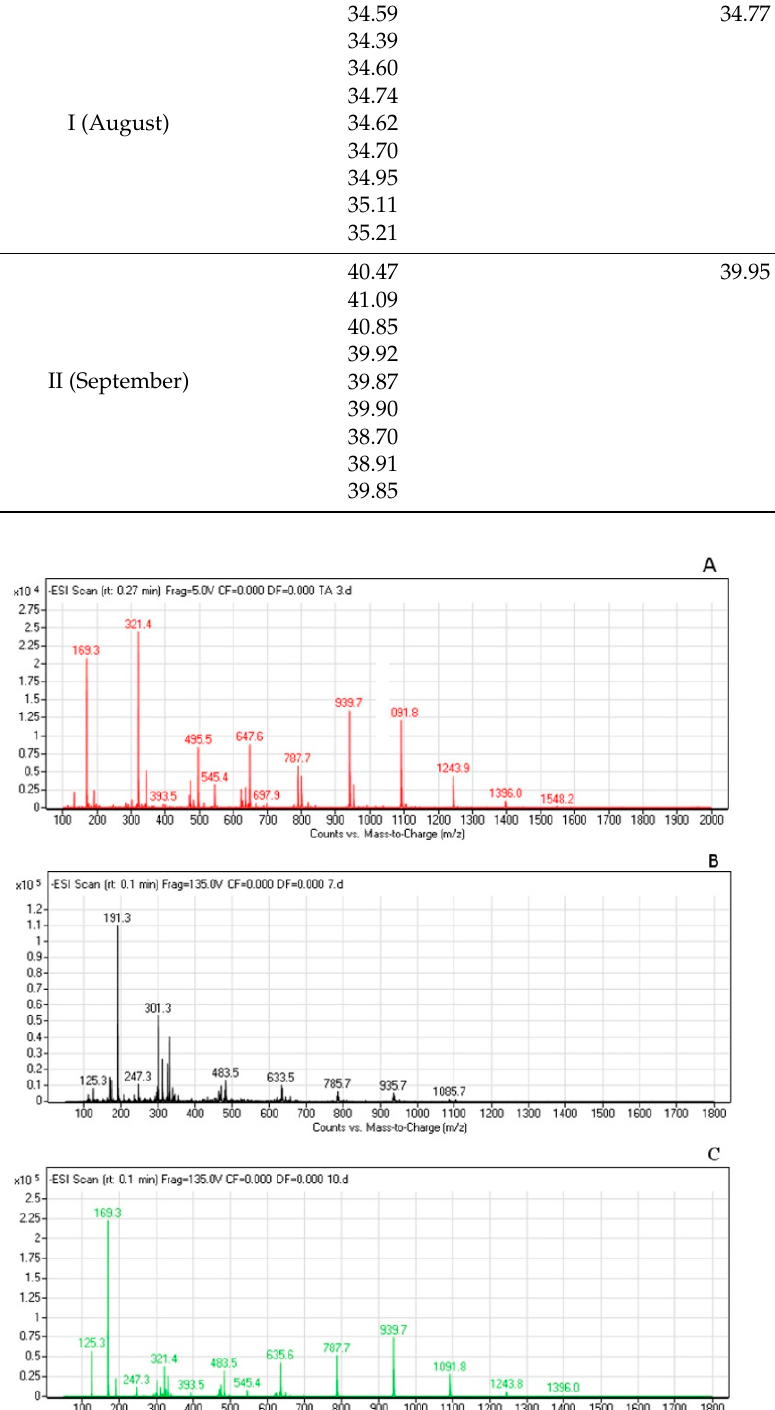
Figure 2. The mass spectrometric signature (-ESI SCAN) of: mixtures of gallic and tannic acid standards GA + TA ( A ) and representatives of the gall nuts samples from the groups C. quercusfolii ( B ) and A. infectorius ( C ).